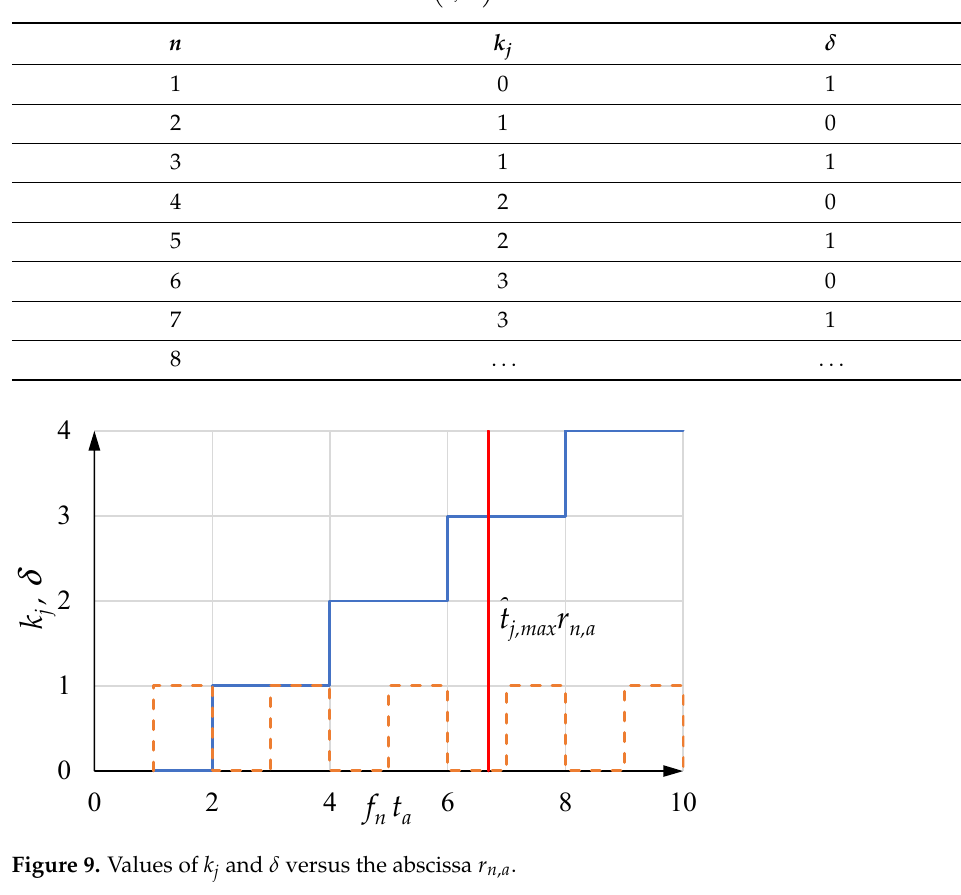
Table 1. Progressive values of the couples